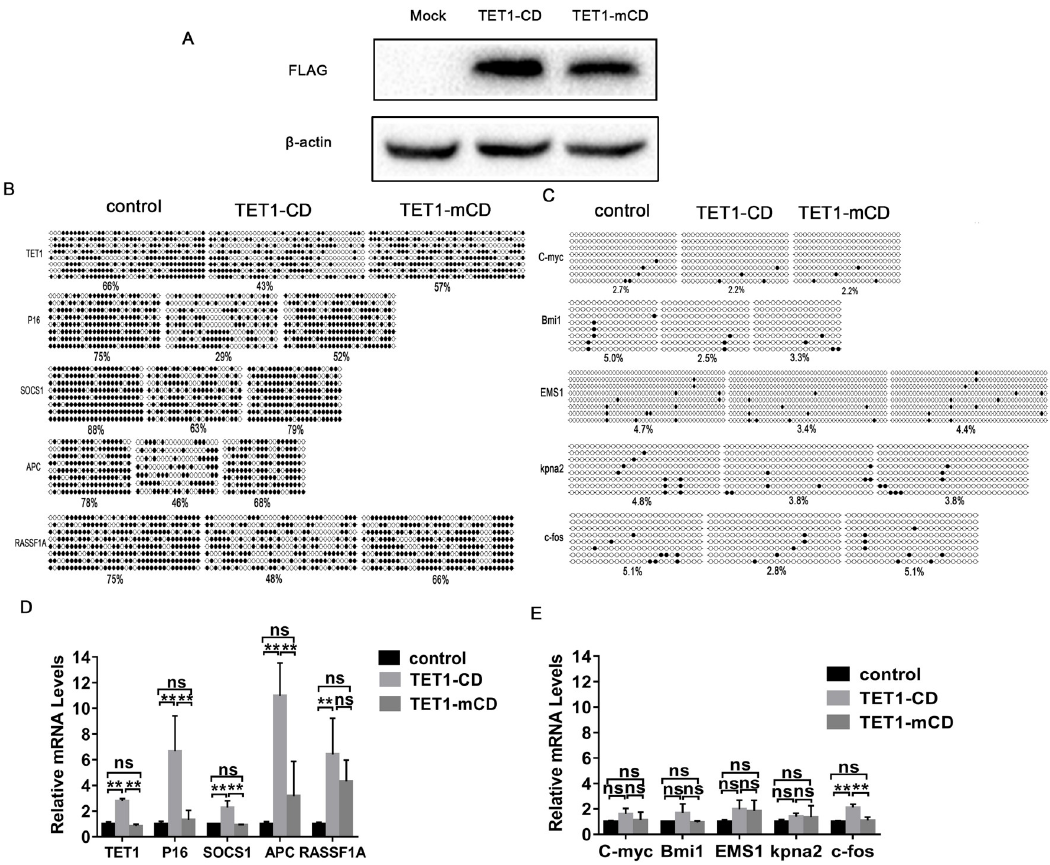
Fig 2. TET1-CD up-regulates TSGs expression. (A). The SMMC 7721 cells were transiently transfected with either TET1-CD plasmids or TET1-mCD plasmids. Expression of TET1-CD and TET1-mCD proteins was analysed by Western blot, and β -actin was used as an internal control. (B)&(C). The SMMC 7721 cells were cultured in the 6 mm plate for 24h and then transiently transfected with either pflag-CMV4 vector (control), TET1-CD or TET1-mCD. Expression of TSGs and oncogenes was analyzed by Quantitative RT-PCR 48h after transient transfection, and the results were represented as mean ± SD of three independent experiments. � p < 0.05, �� p < 0.01, ��� p < 0.001. (one-way